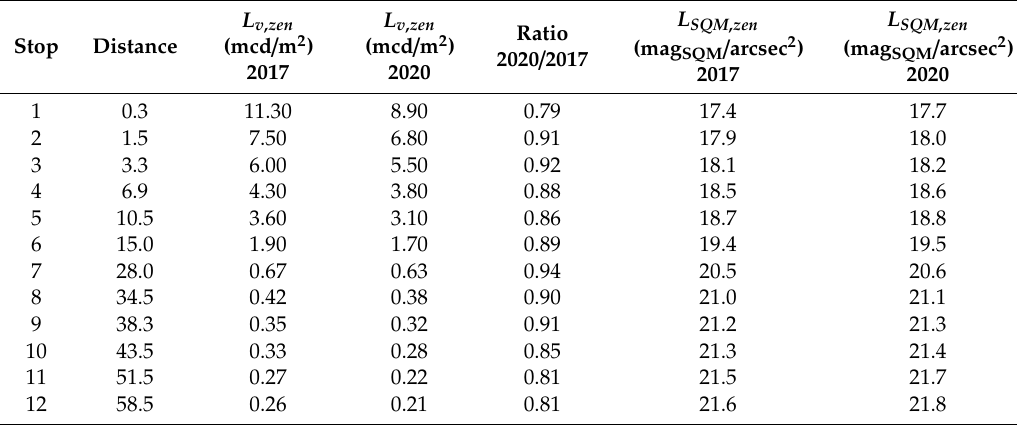
Figure 4. Zenith luminance at different distances from the city center of Berlin, Germany, measured during a clear night in 2017 (black solid line and circles) and a clear night during the COVID-19 lockdown in 2020 (grey dashed dotted line and boxes). Table 1. Zenith luminance ( L v , zen ) data for the two measurement transects and ratios between the two datasets obtained by dividing the zenith brightness values from 2020 by that of 2017.